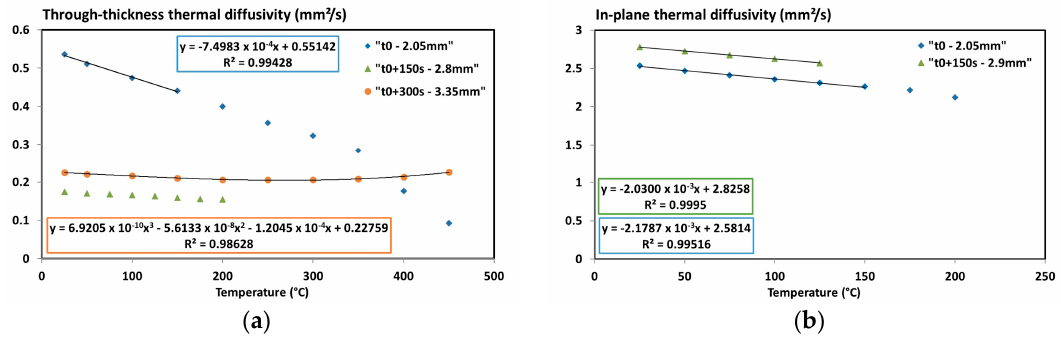
Figure 7. ( a ) Through-thickness; and ( b ) In-plane thermal diffusivities of the T700/M21 composite (virgin, half-degraded and degraded states) as a function of the temperature [6].